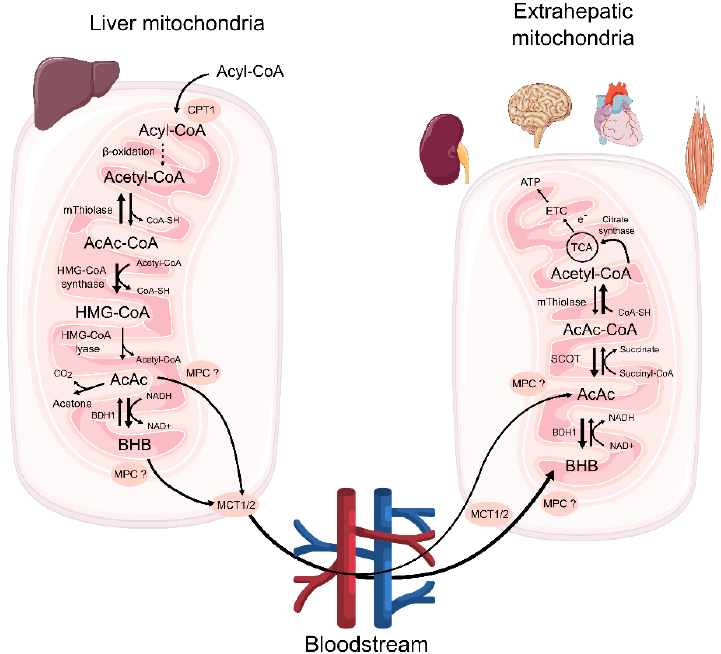
Figure 1. The metabolism of ketone bodies. Ketone bodies are produced in mitochondria of hepatocytes during ketogenesis, whereas utilization of ketone bodies takes place in the mitochondria of peripheral extrahepatic tissues during ketolysis. AcAc—acetoacetate; BDH1—D- β -hydroxybutyrate dehydrogenase; BHB— β -hydroxybutyrate; CPT1—carnitine palmitoyltransferase 1; ETC—electron transport chain; HMG-CoA—3-hydroxy-3-methylglutaryl-CoA; MCT1/2—monocarboxylate